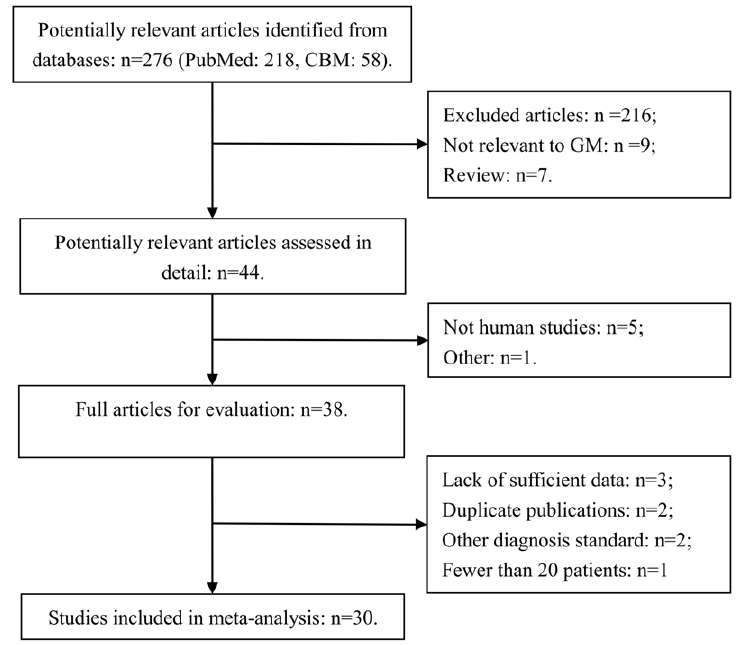
Figure 1. Flow diagram of study selection process.